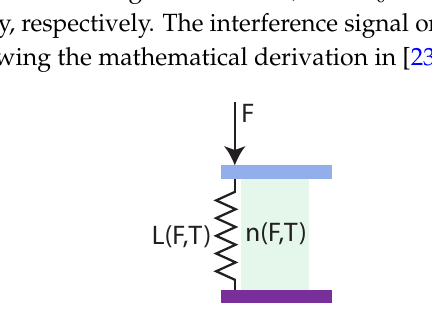
Figure 1. Simplified model of the Fabry-Pérot interferometer inside the force sensor, showing the mirrors of the FPI in purple and light blue with an FPI cavity medium in between with a refractive index n that depends both on temperature and stress inside the medium resulting from the force applied on the sensor. The mirrors are separated by an elastic element with distance L that depends on the temperature of the sensor and the force exerted on the elastic element.